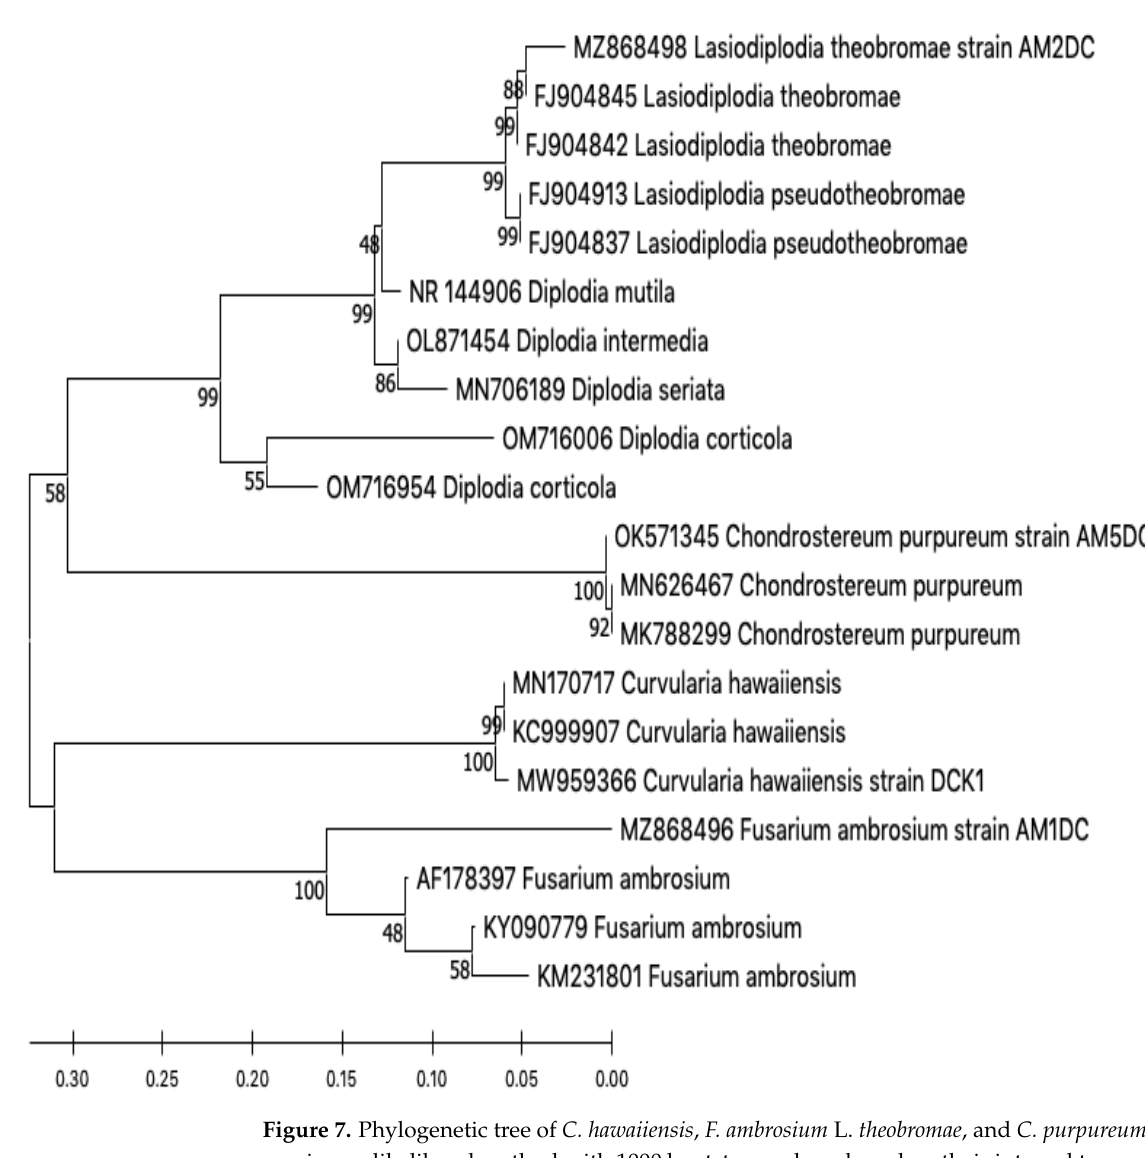
Figure 7. Phylogenetic tree of C. hawaiiensis , F. ambrosium L. theobromae , and C. purpureum using the maximum likelihood method with 1000 bootstrap values, based on their internal transcribed (ITS) and calmodulin (cmdA), showing the position of our fungi that were clustered with their references.